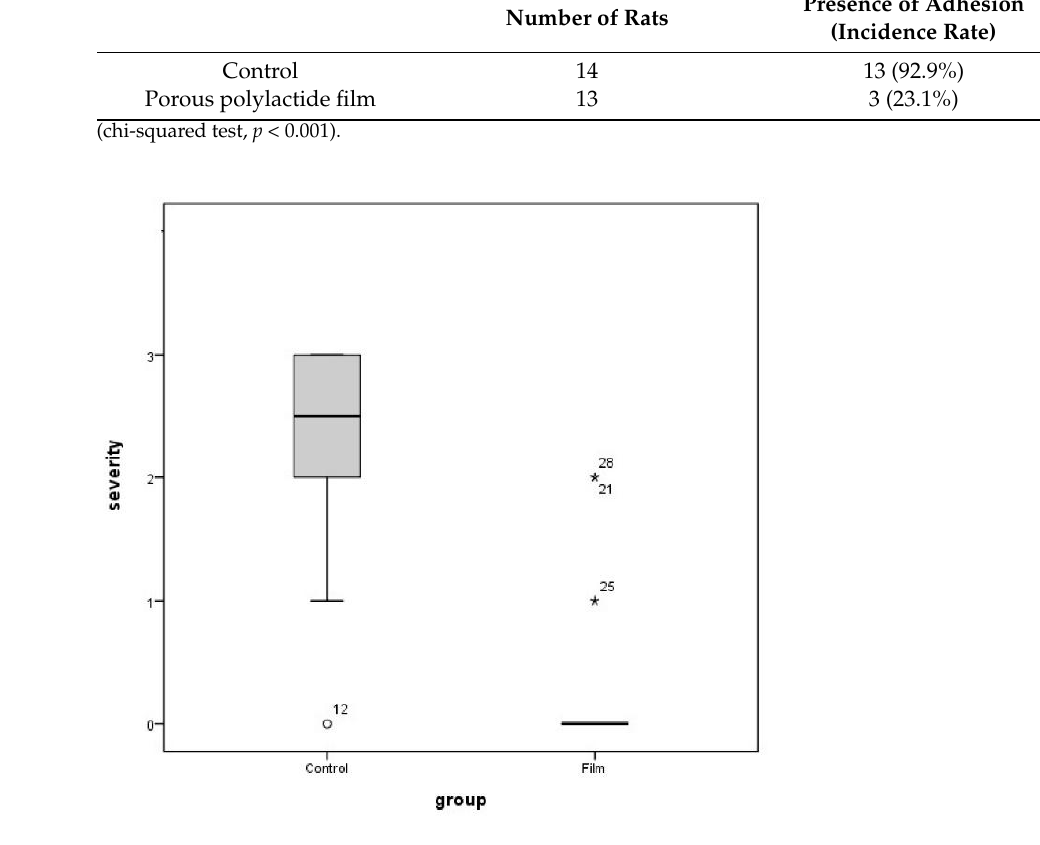
Figure 10. Graphical representations of the adhesion severity scores of the two groups. Median (line within the box), interquartile range (box), and range (error bars) are shown. The differences are statistically significant between the two groups (Mann–Whitney U-shaped test, p < 0.001). Note: represents no adhesion cases in the control group (rat number 12). represents no adhesion cases in the test group (rat numbers 21, 25, and